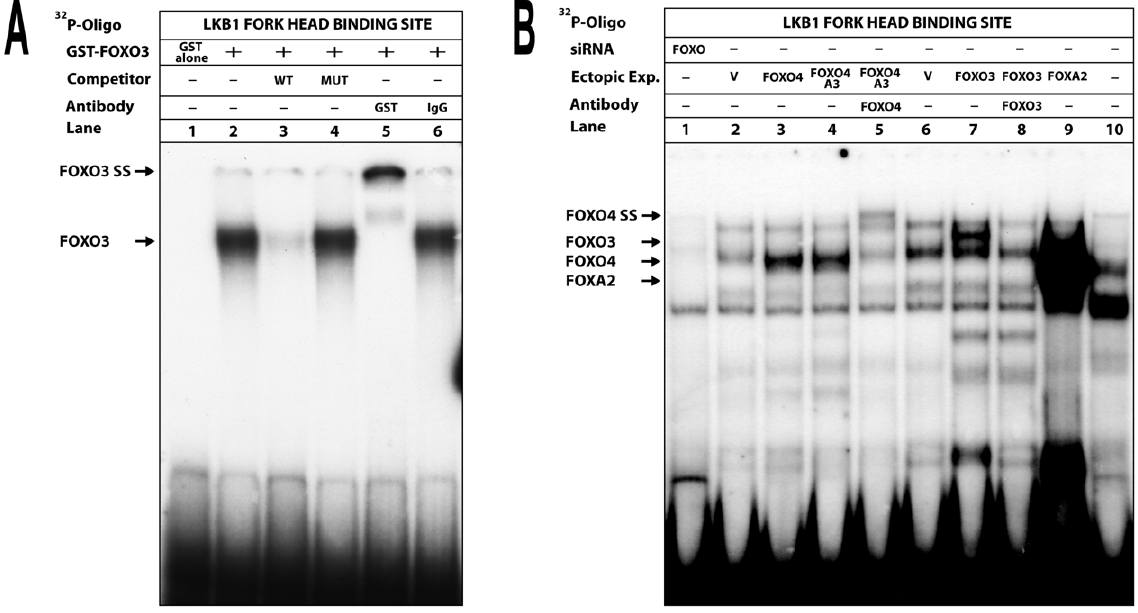
Figure 5. Binding of forkhead box transcription factors FOXO3 and FOXO4 to the LKB1 promoter. ( A ) The 32 P-labeled double-stranded oligonucleotide 5 9 -GGGGAGGGAGGTAAACAAGATGGCGGC-3 9 containing the 2 28 to 2 2 region of the LKB1 core promoter was incubated with either 25 ng of recombinant GST (lane1) or GST-tagged FOXO3 protein (lane 2–6) and separated in a 4% polyacrylamide gel. ( B ) The same oligonucleotide as described in (A), but incubated with 4 m g of nuclear extracts from ‘‘444’’ cells (lanes 1–9) or from HepG2 cells (lane 10) in the presence of a 500-fold molar excess of the mutant unlabeled oligo 5 9 -GGGGAGGGAGGTAGCCAAGATGGCGGC-3 9 . Protein complexes containing the transcription factors FOXO3, FOXO4 and FOXA2 are indicated by arrows. Cells were transfected with either siRNA against the FOXO family members (lane1) or with expression plasmids encoding FOXO4 (lane 3), mutant FOXO4 A3 (lane 4 and 5), FOXO3 (lane 7 and 8), FOXA2 (lane 9) or with the corresponding empty vectors (V) (lane 2 and 6). Addition of an antibody against FOXO4 (lane 5) resulted in further retardation of the FOXO4 containing complex (FOXO4 SS), while addition of the FOXO3 antibody (lane 8) inhibited formation of the FOXO3 complex.